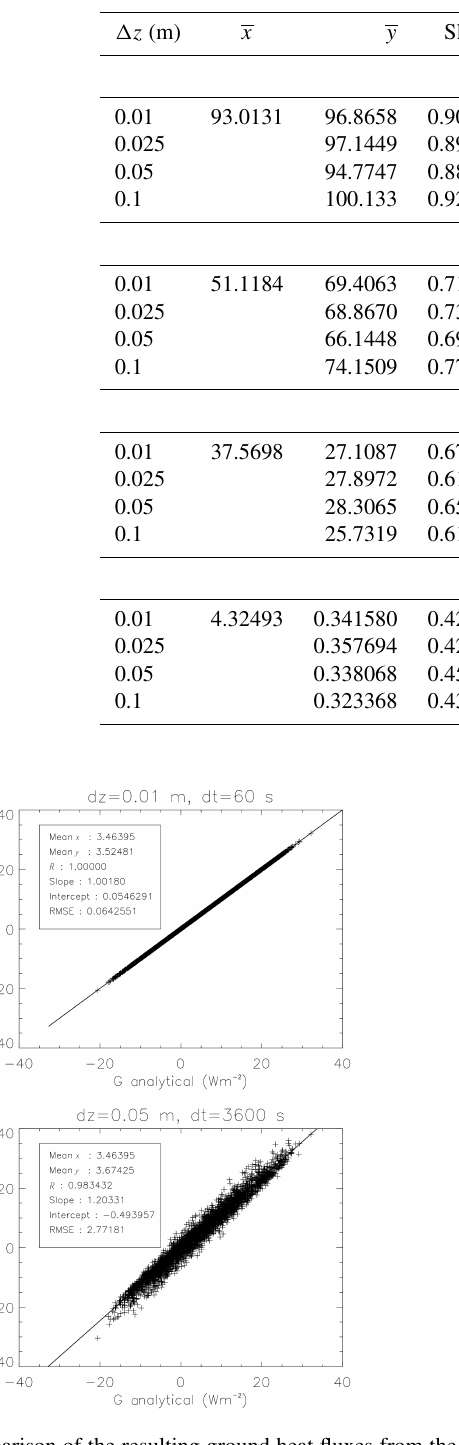
Table 4. Results of the linear regressions between the energy balance observations ( x axis) and the simulations ( y axis) for the simulations with an analytical solution of the heat conduction equation. Units are Wm − 2 .